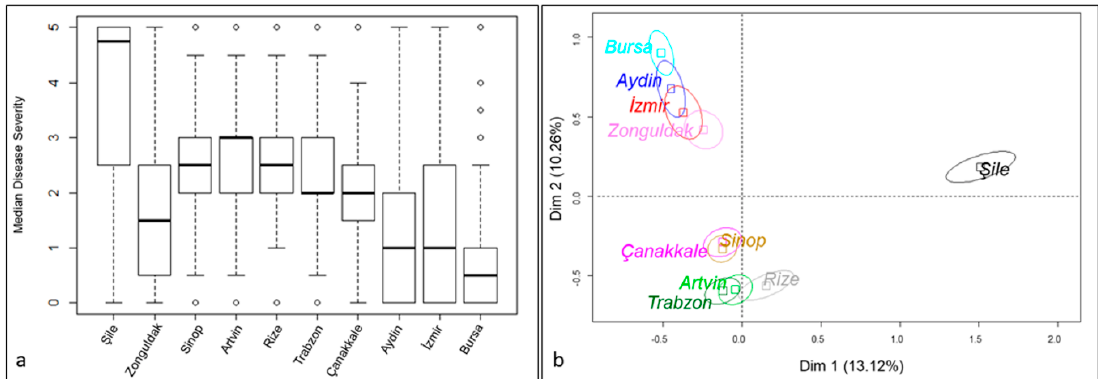
Figure 2. ( a ) Boxplot of median disease severity scores of chestnut trees by site number; ( b ) Results of 263 multiple correspondence analysis of all disease severity scores and site number, with site number 264 revealed by a 95% confidence ellipse. 265